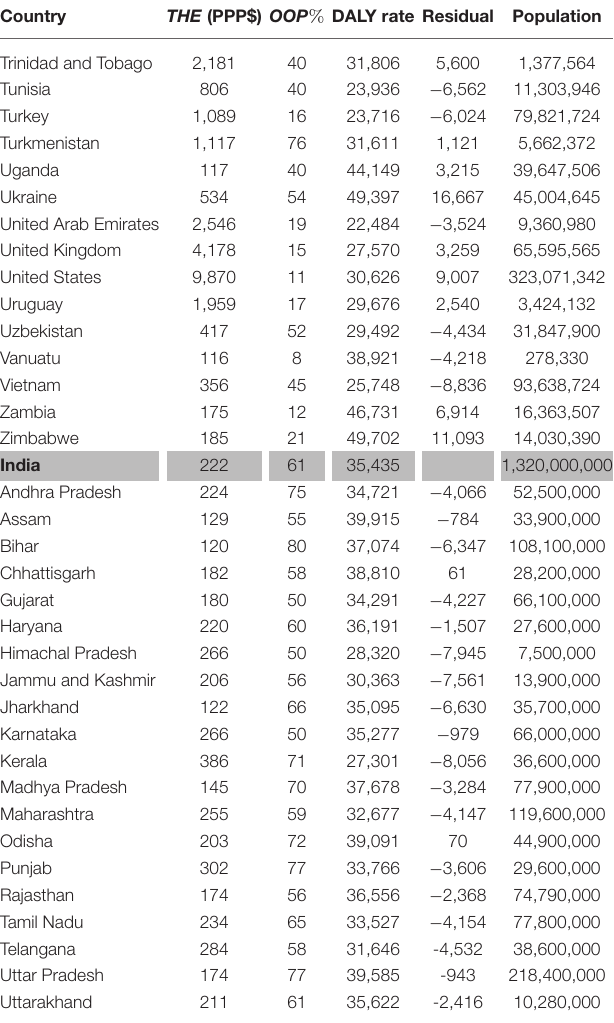
TABLE 15 | Estimated residuals for each country (Trinidad and Tobago to Zimbabwe; India and Indian States). Country THE (PPP$) OOP % DALY rate Residual Population Trinidad and